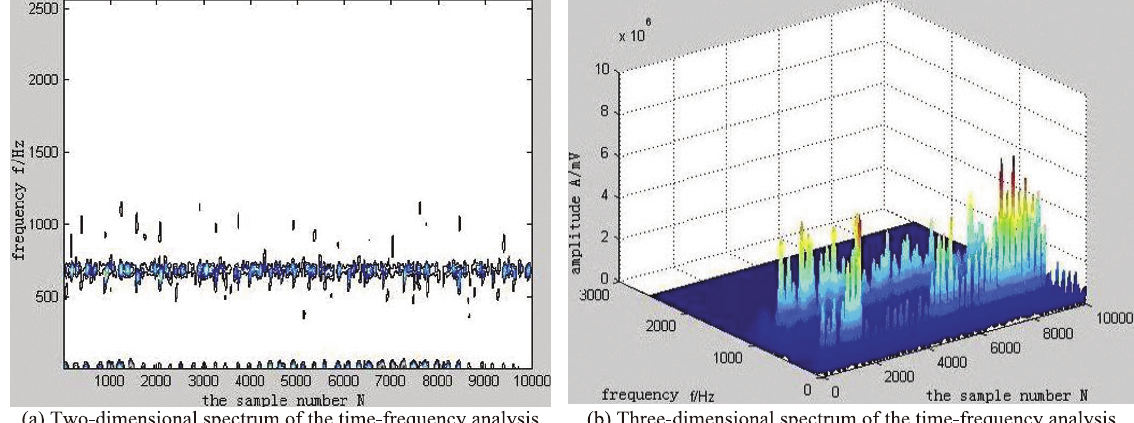
Fig. 10. The time frequency analysis of a tooth root crack signal at 900